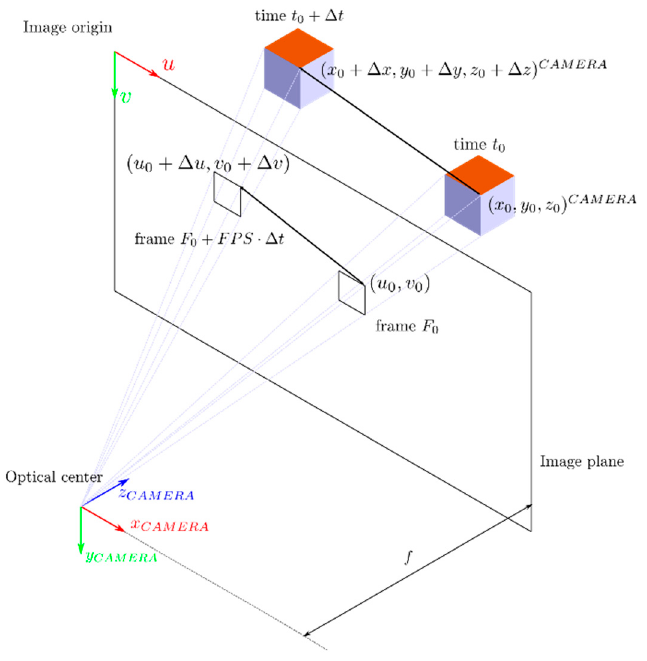
Figure 11. Working principle of the pinhole camera model applied to a moving object.